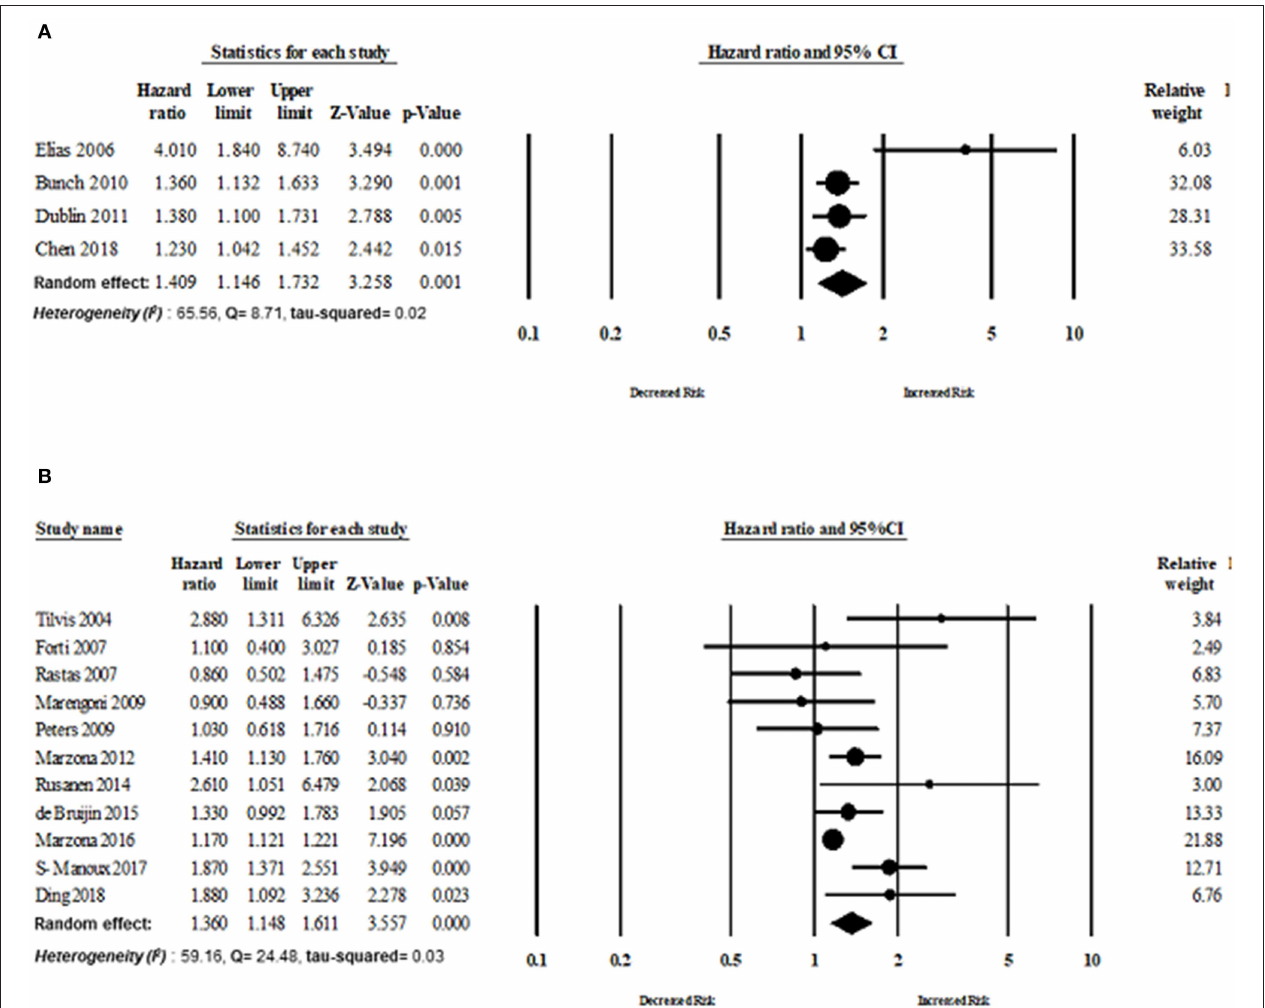
FIGURE 7 | Risk of dementia based on region: (A) Europe, (B) North